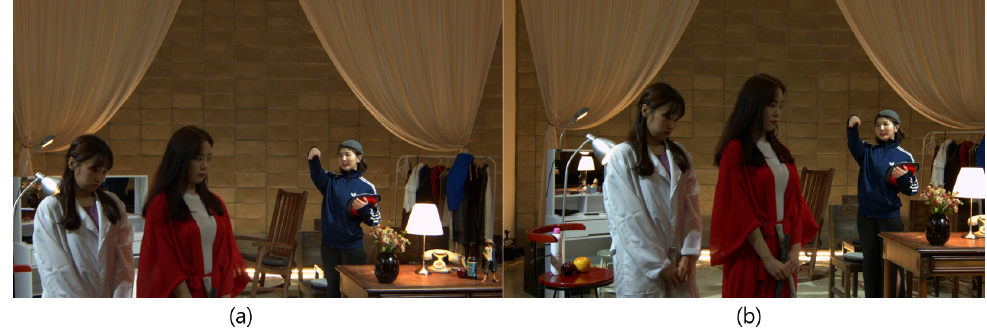
Figure 6. If two images ( a , b ) have different scaling factors, the direct estimation of the disparity is impossible.